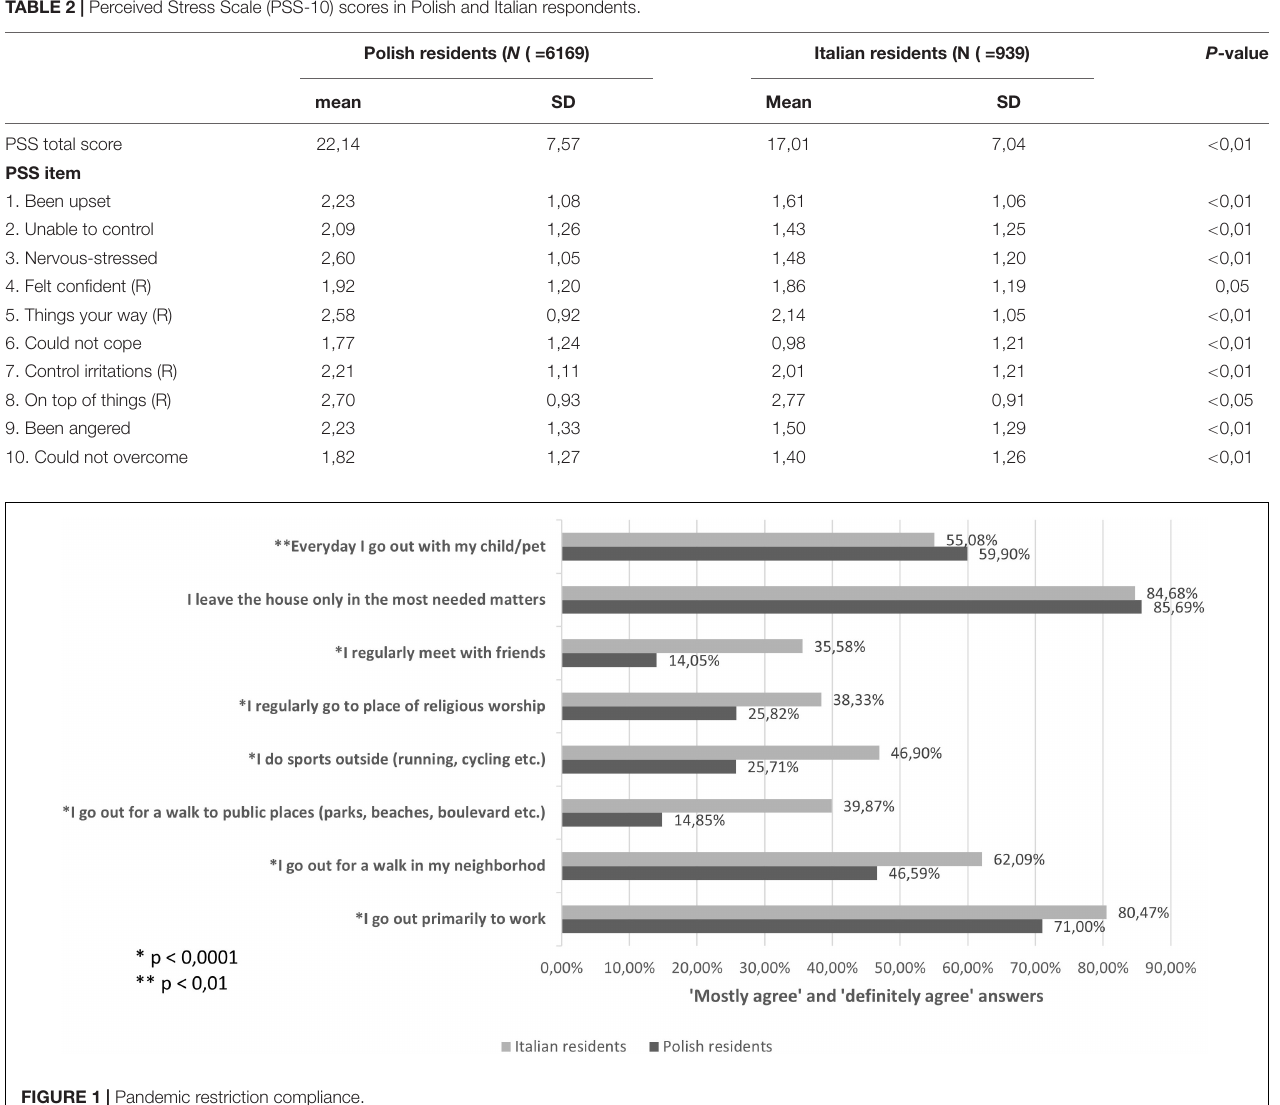
FIGURE 1 | Pandemic restriction compliance.